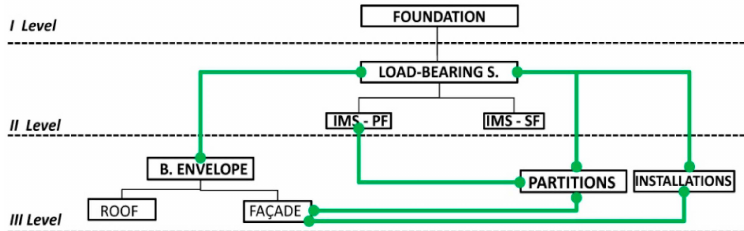
Figure 7. Systematization of the IMS Building Model according to independent technical levels: IMS-PF (primary structure); IMS-SF (secondary